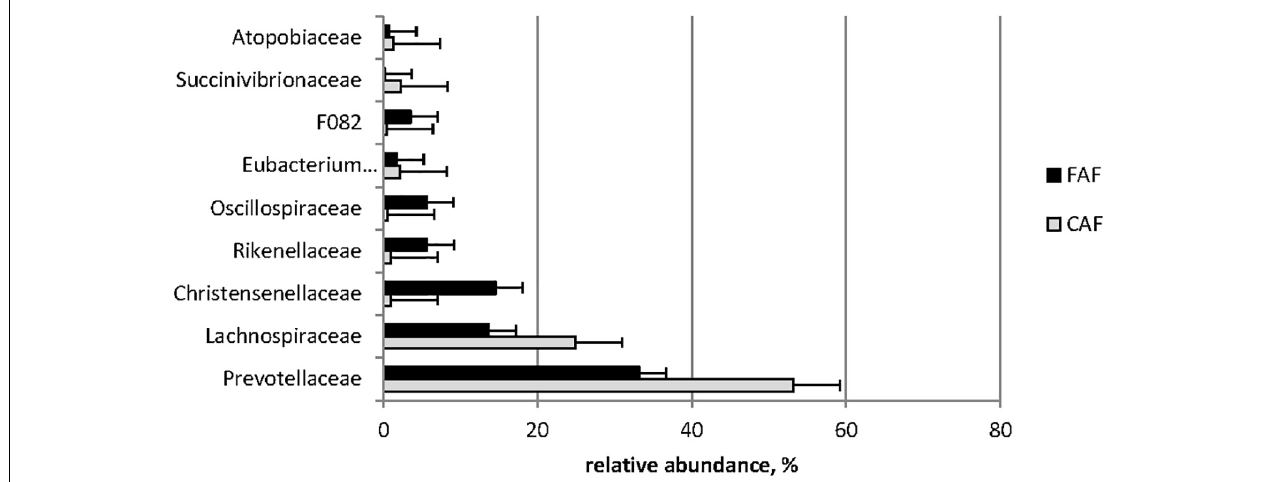
FIGURE 4 | Least-squares means of alpha-diversity traits of lambs’ rumen microbiota significantly different ( P < 0.001) according to the diet: 78 lambs received during a first period a 100% concentrates diet (CAF, ) and then in a second period 62 of them were kept to a 67% hay diet (FAF, ).